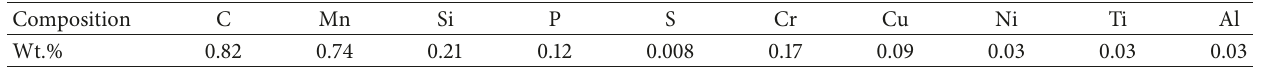
Table 2: Chemical composition of alloying elements of the prestressing